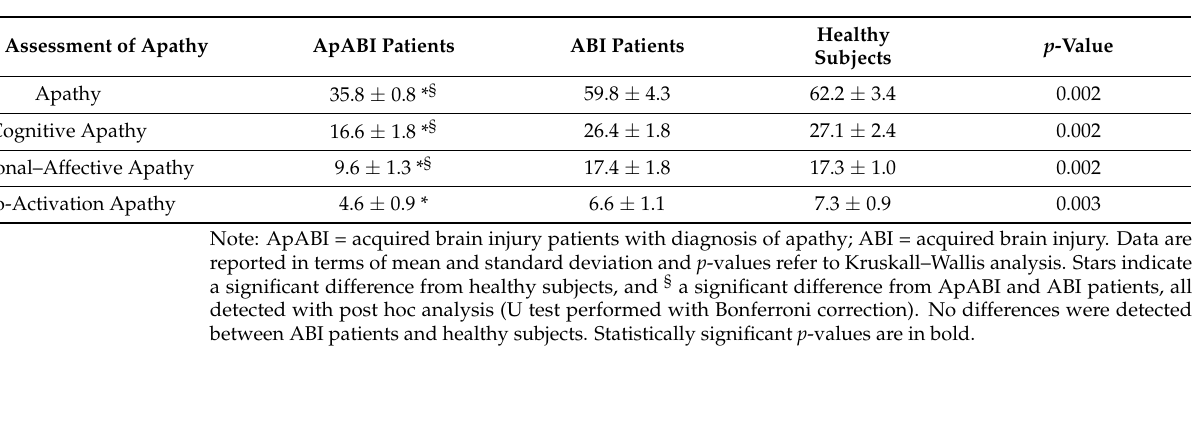
Table 4. Assessment of apathy in ApABI and ABI patients, and healthy